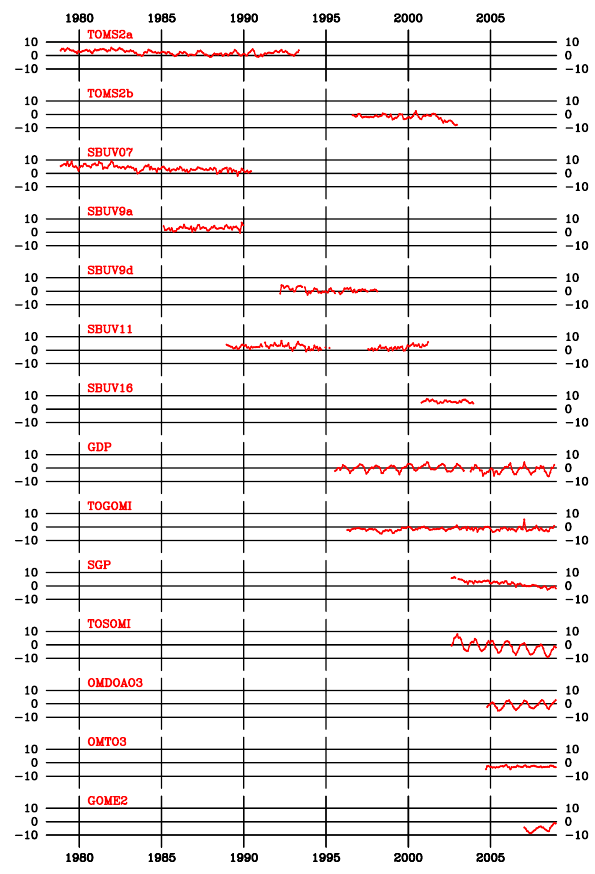
Fig. 2a. Monthly averaged and globally averaged difference of the satellite ozone observation minus the ground observation in units of DU, for all satellite data sets used as function of